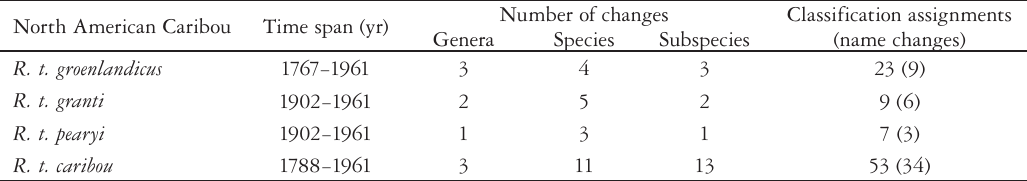
Table 1. Number of classification assignments and name changes in the taxonomic nomenclature for North American caribou between 1767 and 1961: derived from Banfield (1961). North American Caribou Time span